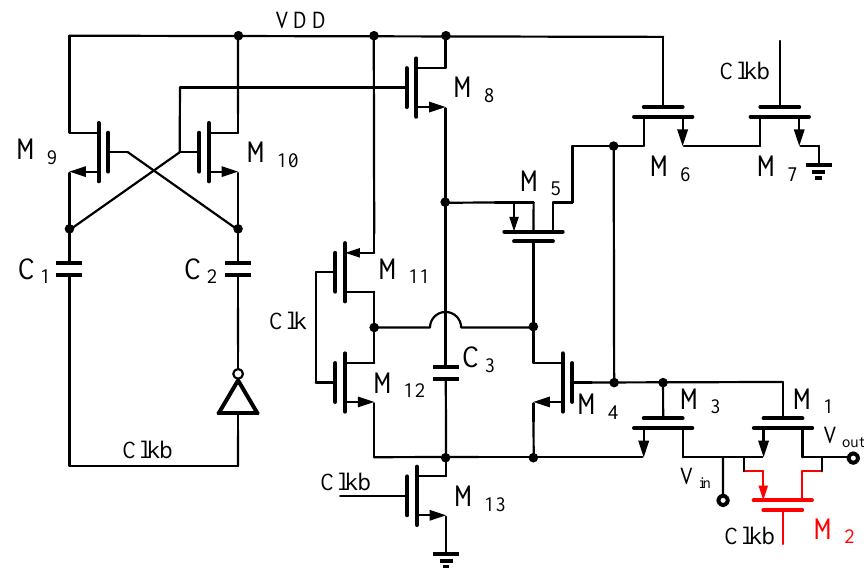
Figure 10. The proposed bootstrap switch circuit with complementary switch transistors.